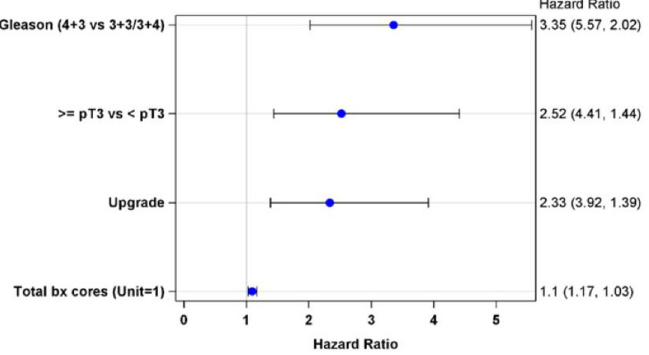
Fig 3. Multivariate analyses of factors predictive of time to PSA failure. Odds ratios (with 95% confidence interval in parenthesis) of factors predictive of time to PSA failure.